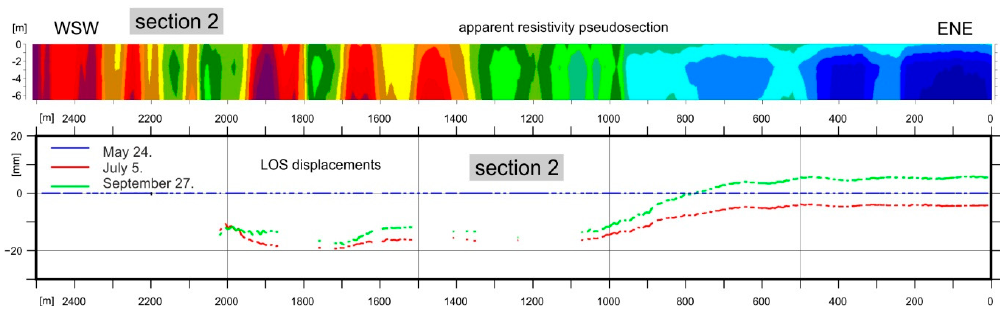
Figure 11. Comparison of the ground electrical resistivity and vertical displacements of the terrain surface (LOS SBAS). The May 24 is the reference point for LOS SBAS analysis.